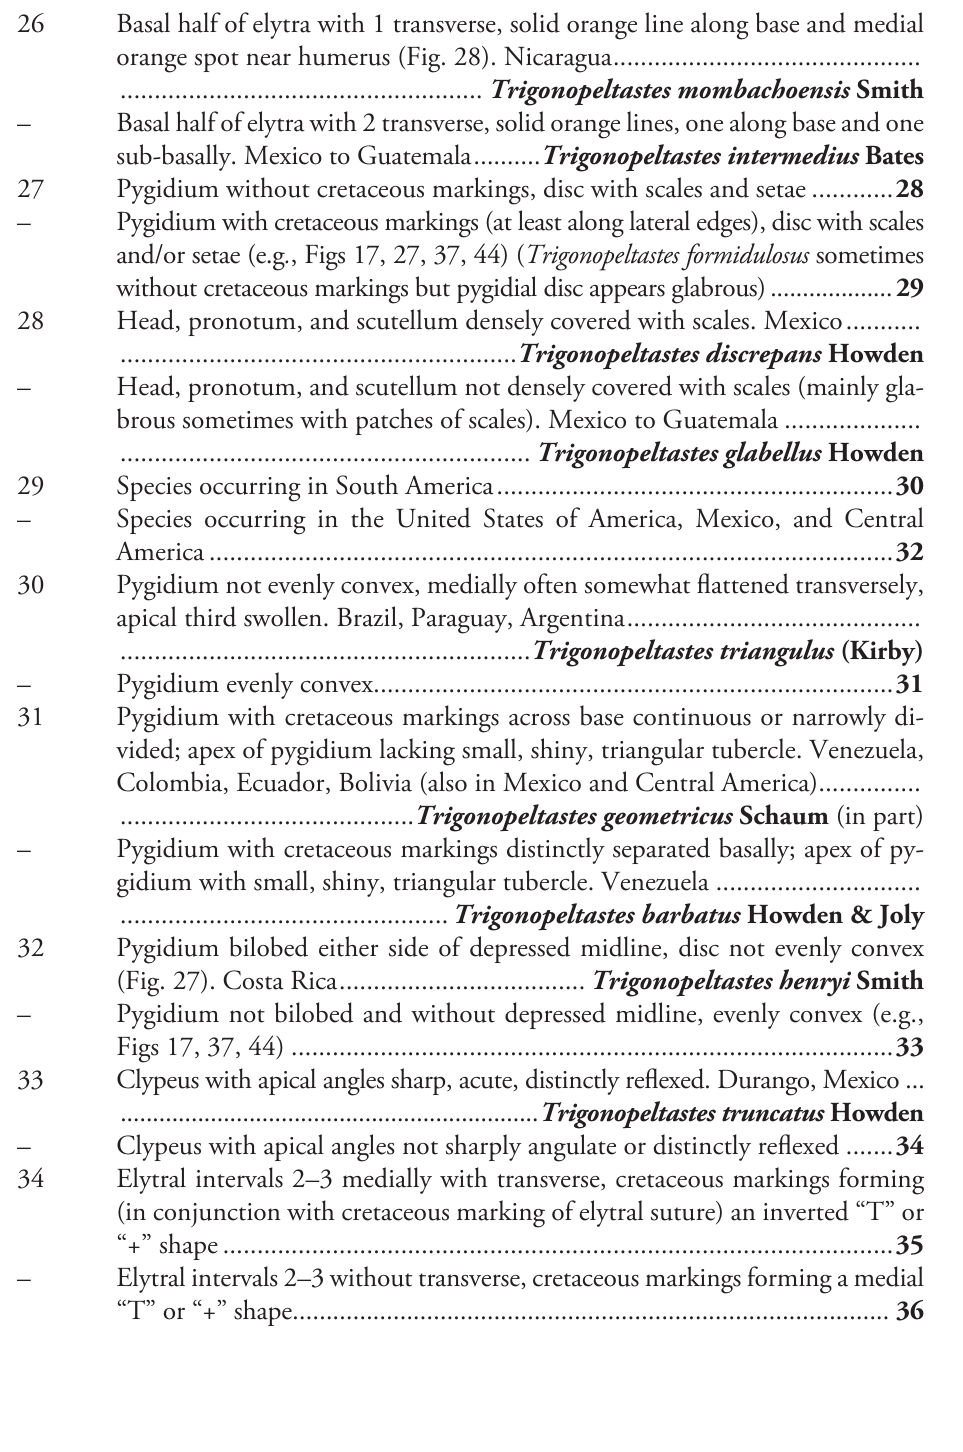
– Basal half of elytra with 2 transverse, solid orange lines, one along base and one